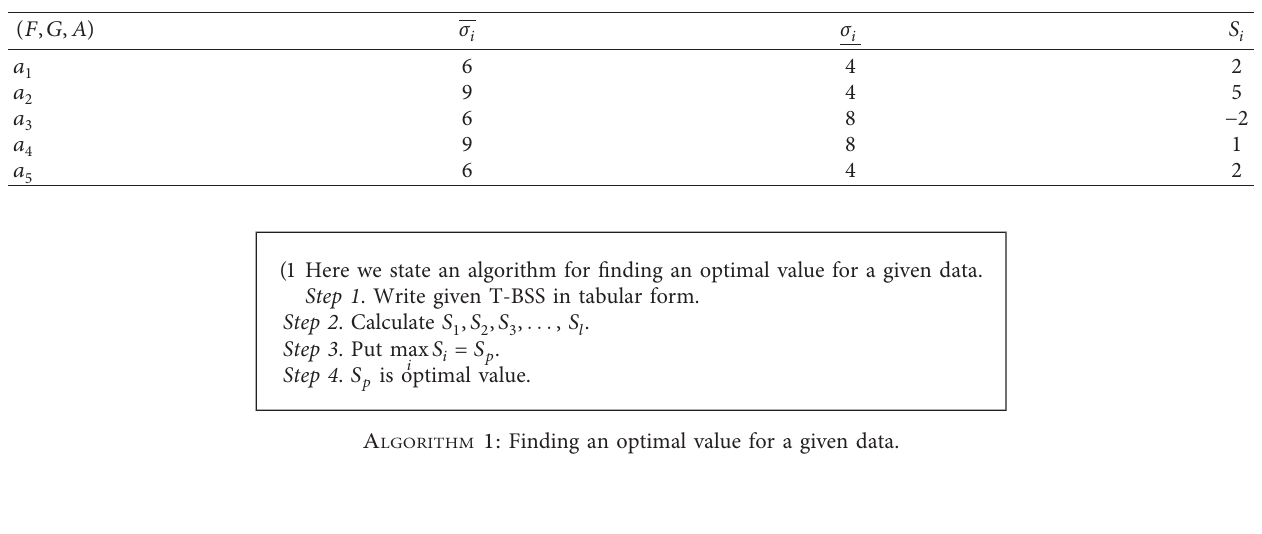
Table 5: Weight values.